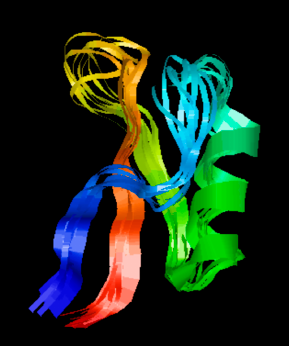
Figure 1. Secondary structure of defensin-like protein 1 (D-lp1) generated on RasMol demonstrating the triple stranded antiparallel beta-sheets and alpha helix structure present within the pep- tide.